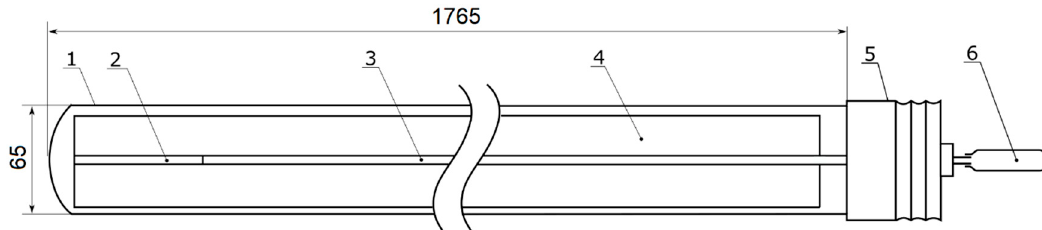
Figure 5. Construction of the vacuum tube of a solar collector. 1—glass cover; 2—evaporator; 3—adiabatic section; 4—absorber; 5—top cover; 6—condenser.